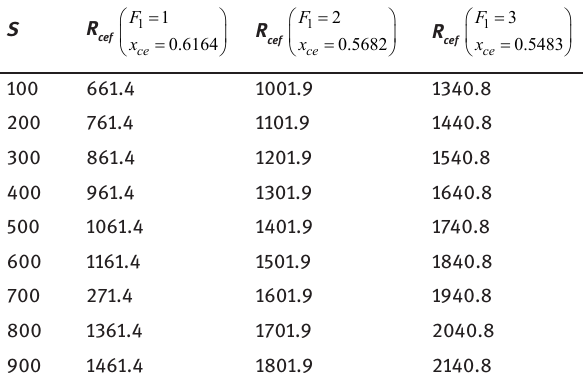
Table 3: The variation in the fluid-based critical thermal Rayleigh number R with the solute gradient ( S cef